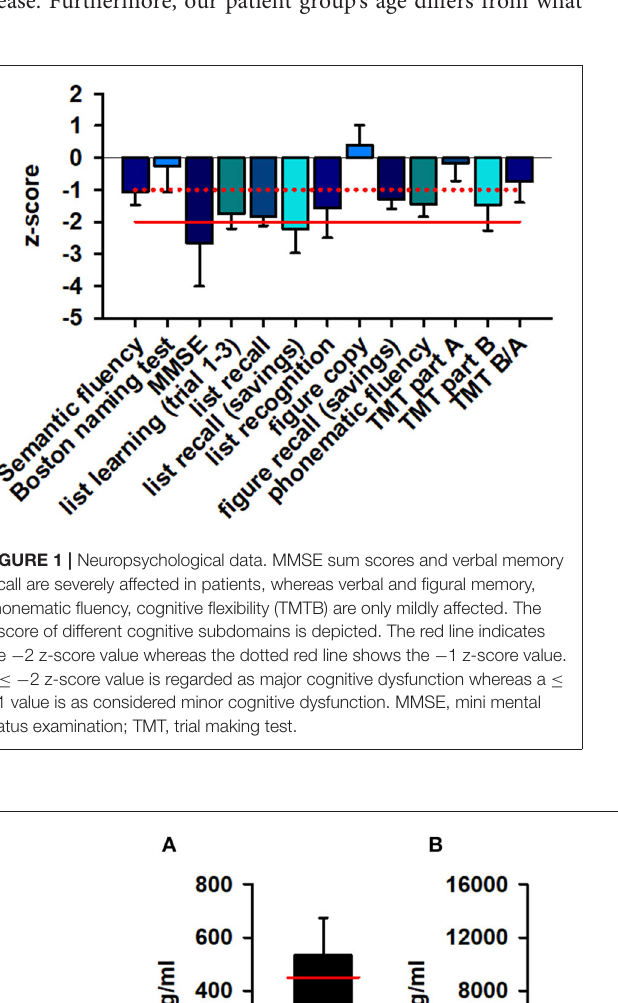
Frontiers in Psychiatry |